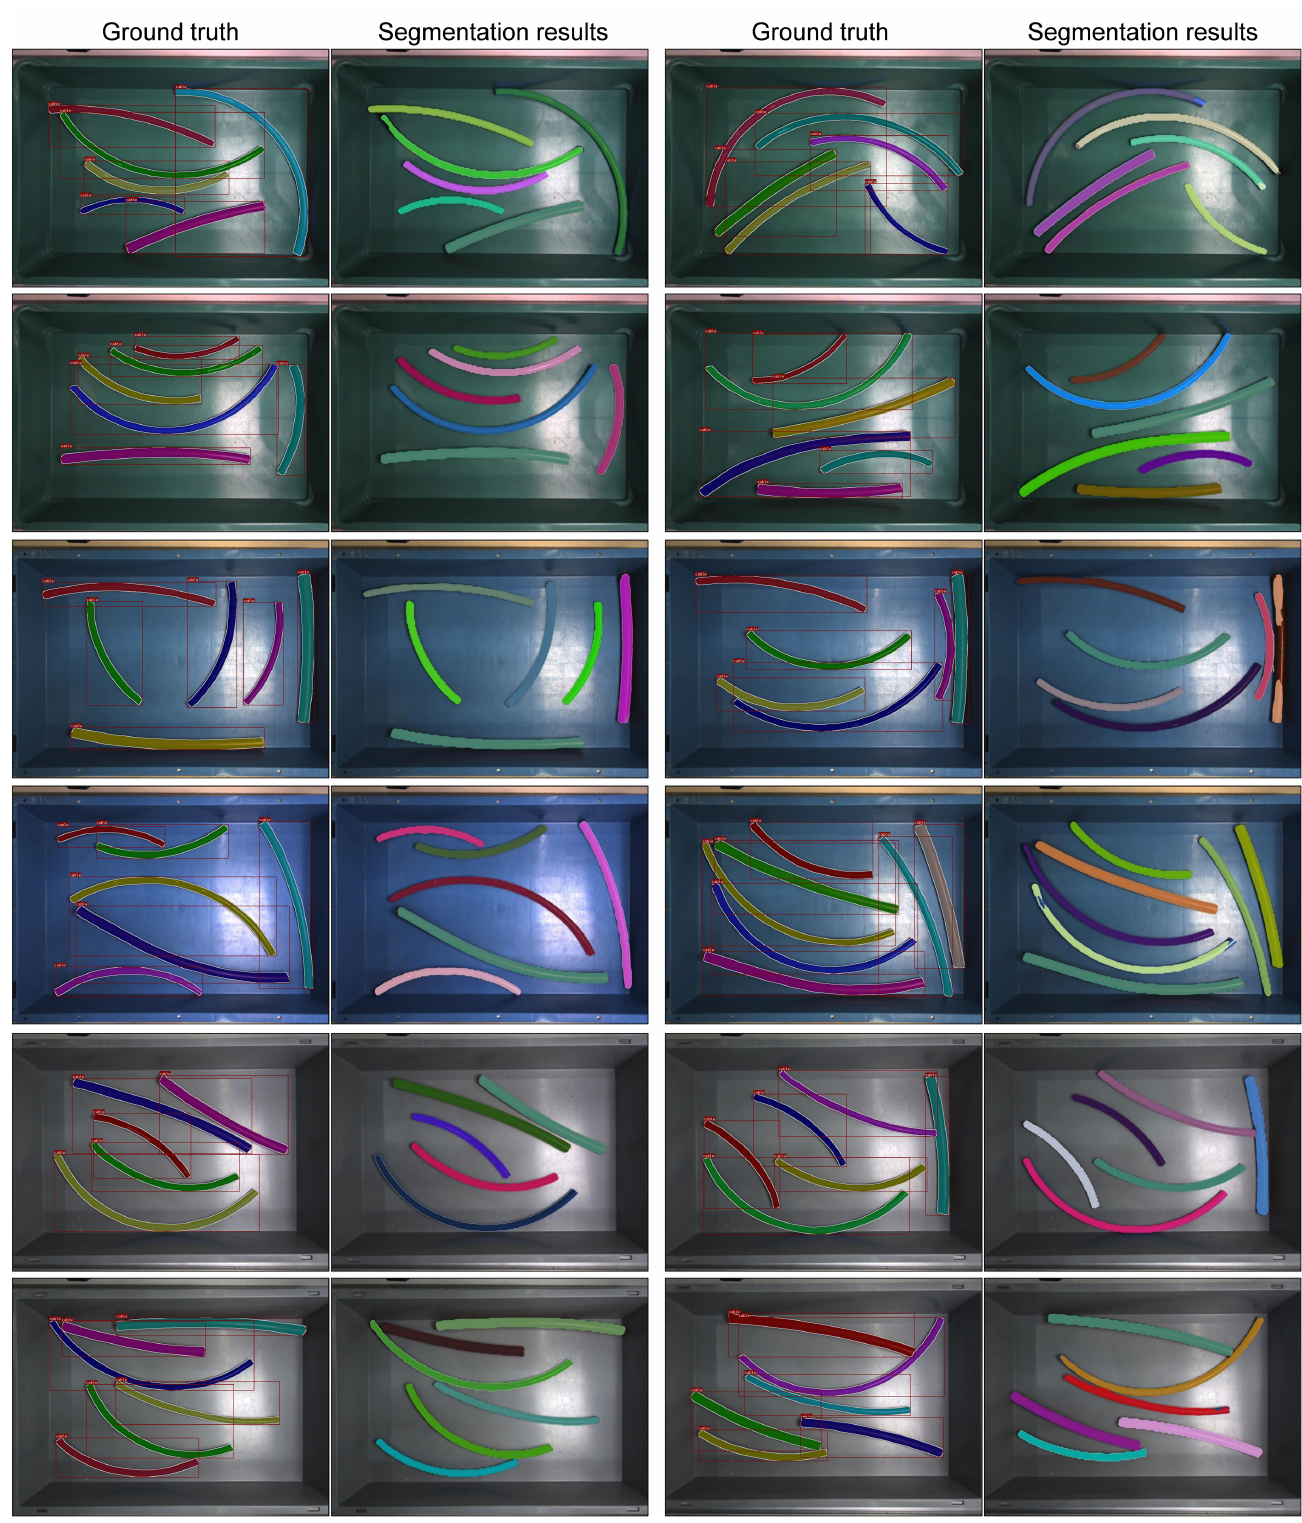
Figure A3. Ground truth masks and instance segmentation results for pneumatic hoses in the scenario